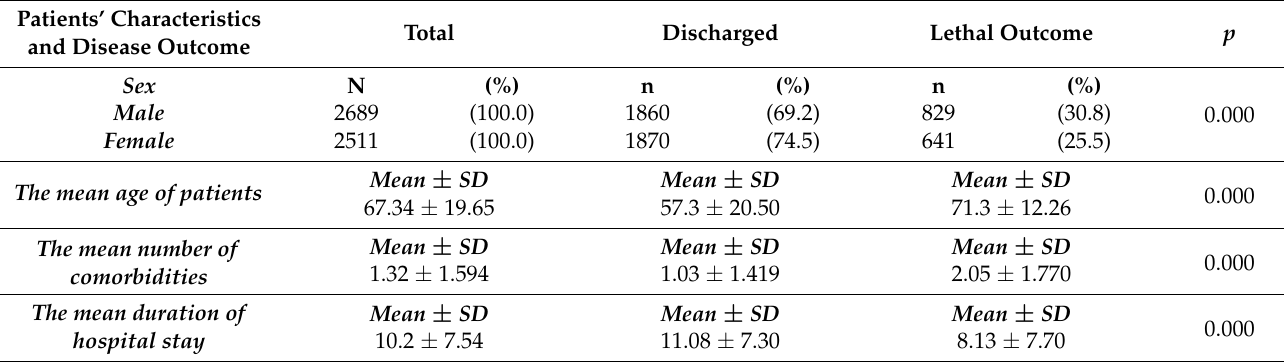
Table 2. Patients’ characteristics and disease